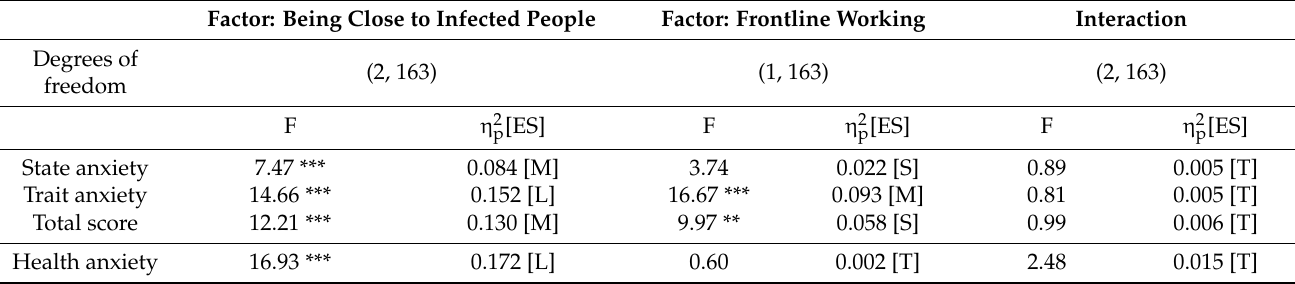
Table 4. Inferential statistical indices for state and trait anxiety and health anxiety, with the factors being close to people infected with COVID-19 and frontline